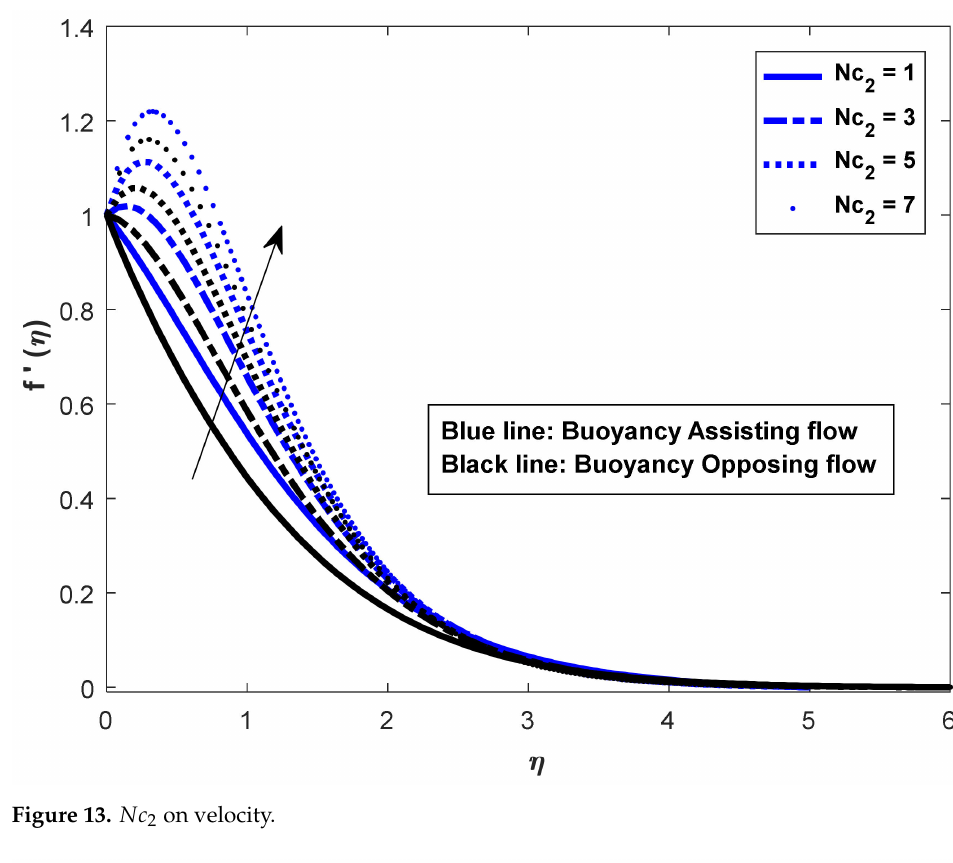
Figure 13. Nc 2 on velocity.